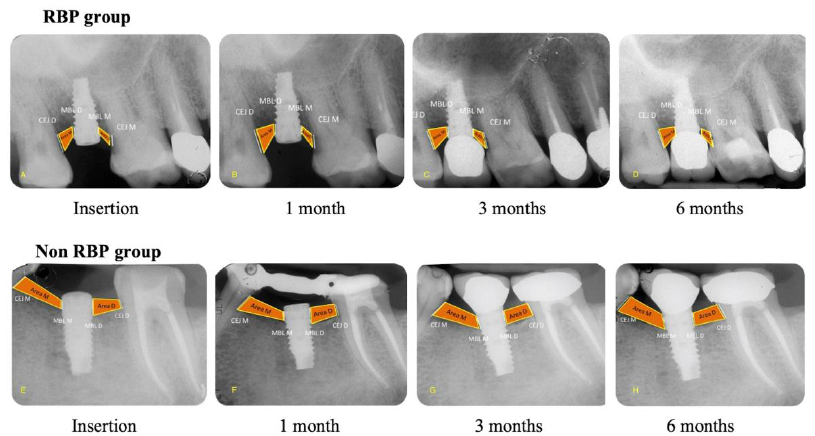
Figure 4. Radiographic evaluation of 2 included cases. The known length and diameter of the implants were used to standardize the calibration of the measurements on each periapical radiograph for MBL-M, MBL-D, Area M, Area D, CEJ-M and CEJ-D as described. ( A ) The implant was inserted in a 48-year-old, nonsmoker male patient in position 45. ( B ) After one